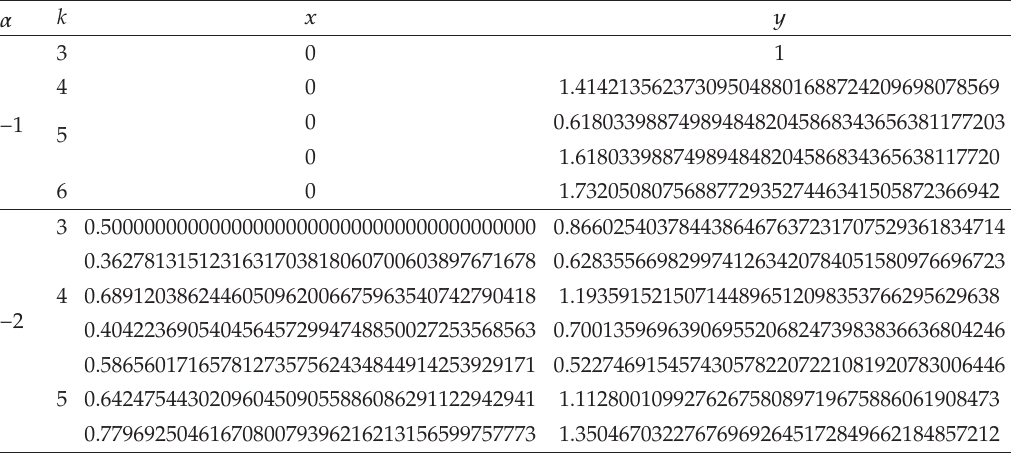
Table 1: Typical coordinates (cid:2) x,y (cid:4) of periodic regions’ centers in general M-sets for α (cid:3) − 1 , − 2.